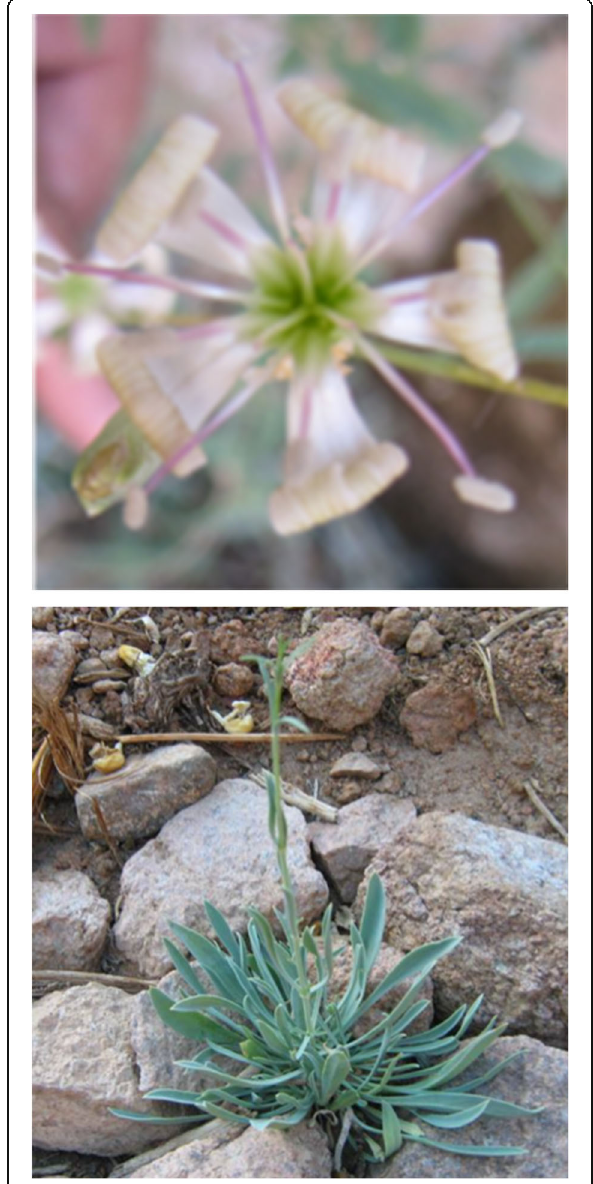
Fig. 2 Silene schimperiana plant growing naturally in Gebel Tennia, Saint Katherine, Southern Sinai, with a close up view of a